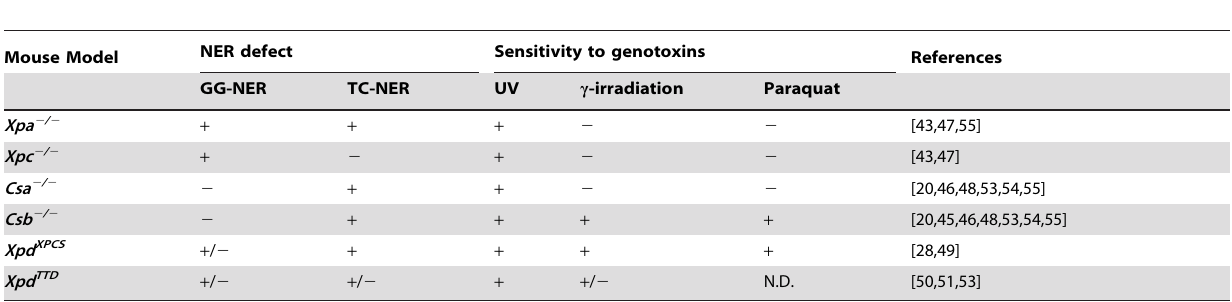
Table 1. NER defect and sensitivity to genotoxins of embryonic fibroblasts isolated from NER–deficient mouse models.